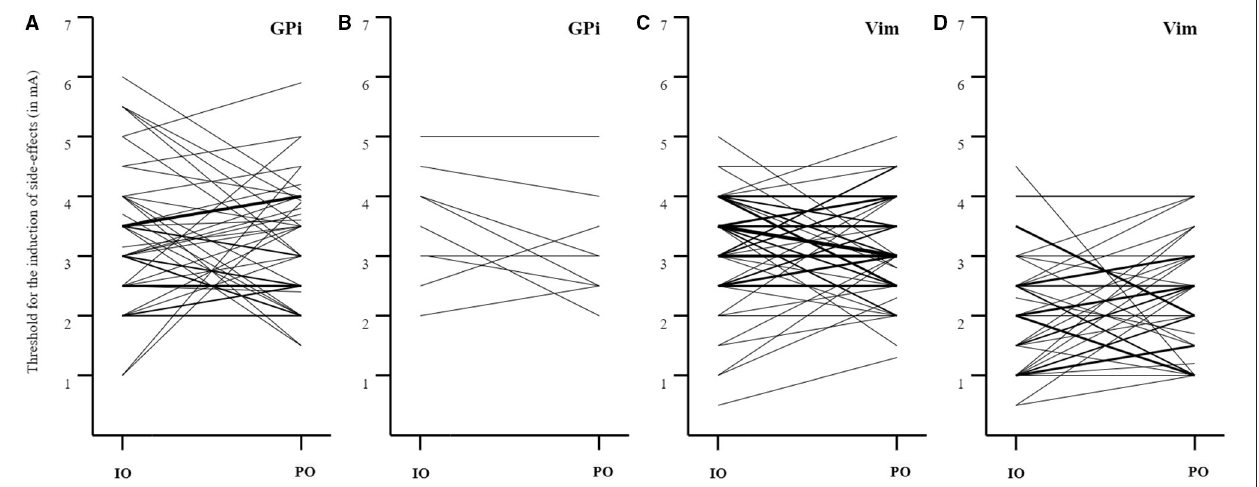
FIGURE 1 | Paired analyses for the induction of capsular and non-capsular side-effects. (A) GPi DBS: induction of capsular side-effects (IO > PO: n = 20; IO < PO: n = 23; IO = PO: n = 5; mean ± SD threshold IO: 3.3 ± 1.1mA, PO: 3.2 ± 1.0mA, mean ± SD difference 1.0 ± 0.9mA); (B) GPi DBS: induction of non-capsular side-effects (IO > PO: n = 5, IO < PO: n = 2, IO = PO: n = 2; mean ± SD threshold IO: 3.5 ± 1.0mA, PO: 3.1 ± 0.9mA, mean ± SD difference 0.6 ± 0.4mA); (C) Vim DBS: induction of capsular side-effects (IO > PO: n = 23; IO < PO: n = 23; IO = PO: n = 14; mean ± SD threshold IO: 3.2 ± 0.9mA, PO: 3.1 ± 0.8mA, mean ± SD difference 0.8 ± 0.6mA); (D) Vim DBS: induction of non-capsular side-effects (IO > PO: n = 14; IO < PO: n = 26; IO = PO: n = 7; mean ± SD threshold IO: 2.1 ± 1.0mA, PO: 2.3 ± 0.9mA, mean ± SD difference 0.9 ± 0.6mA). The thickness of the lines reflects the number of paired observations. IO, intraoperative;